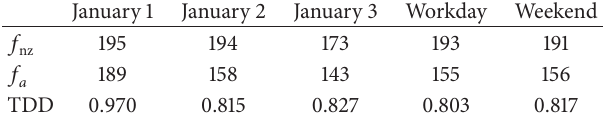
Table 1: TDD values for New Year’s days.